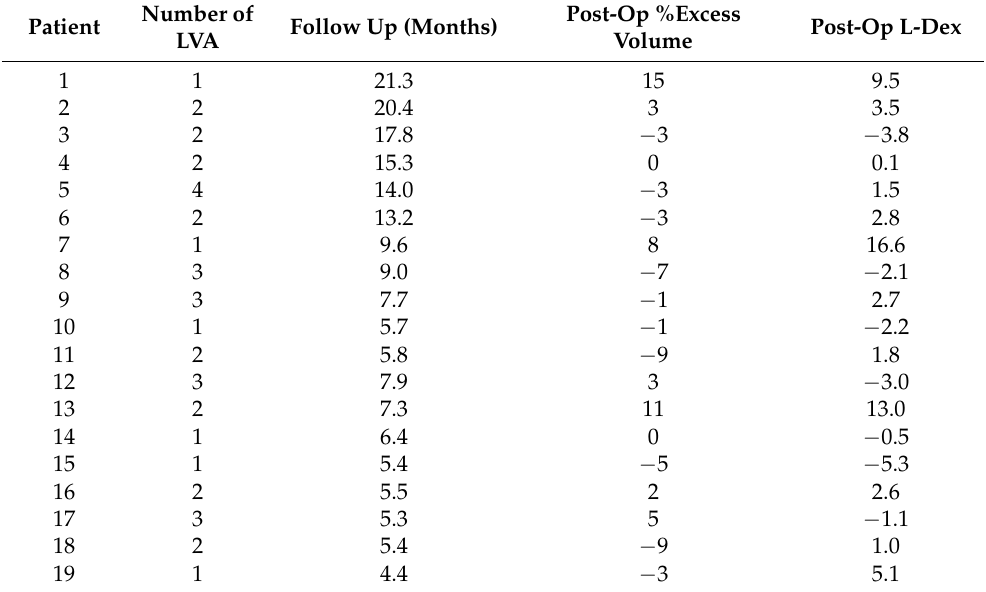
Table 2. Postoperative